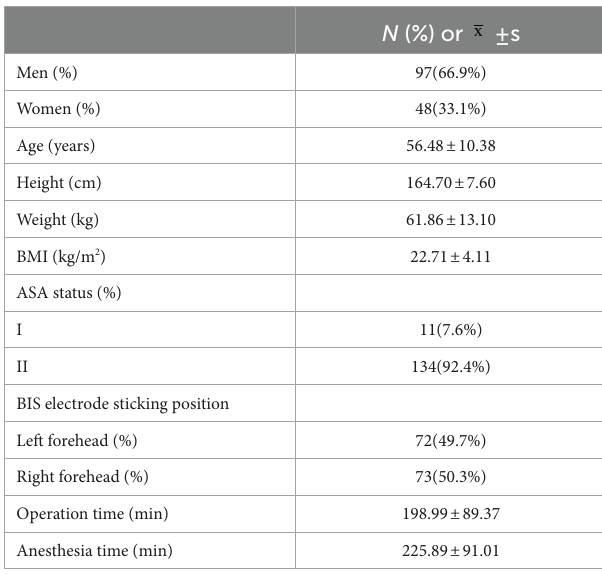
TABLE 1 Characteristics of patients at